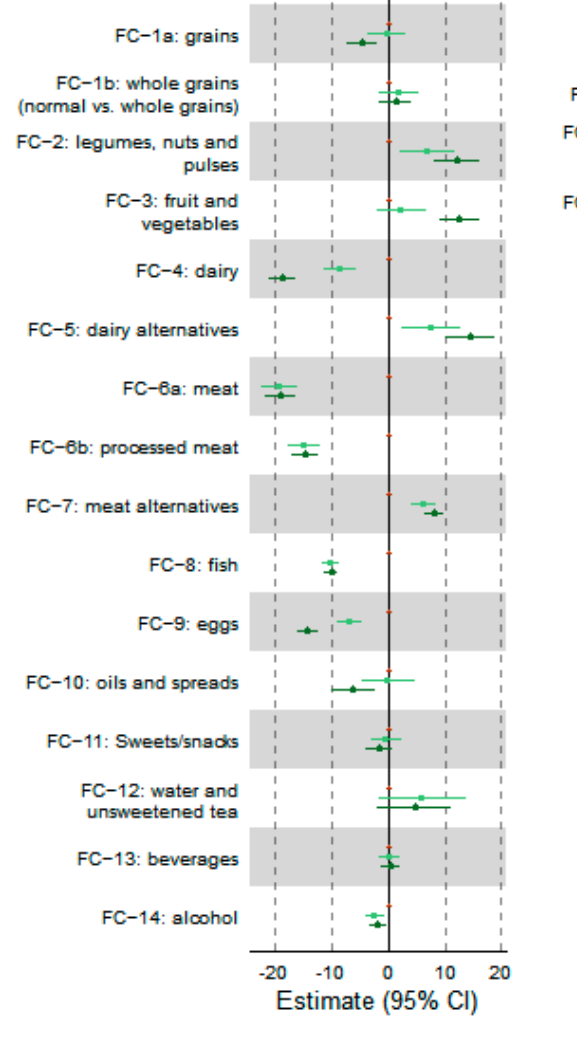
Figure 2. Forest plots with 95% of confidence interval to show the differences between omnivores, vegetarians, and vegans in basic (left column) and umbrella (right column) food clusters. Omnivorous group considered as reference with differences based on variations of vegetarians and vegans from omnivores. FC—food clusters. Table 5. Linear regression results for age- and dietary-based main effects of food clusters with omnivorous reference